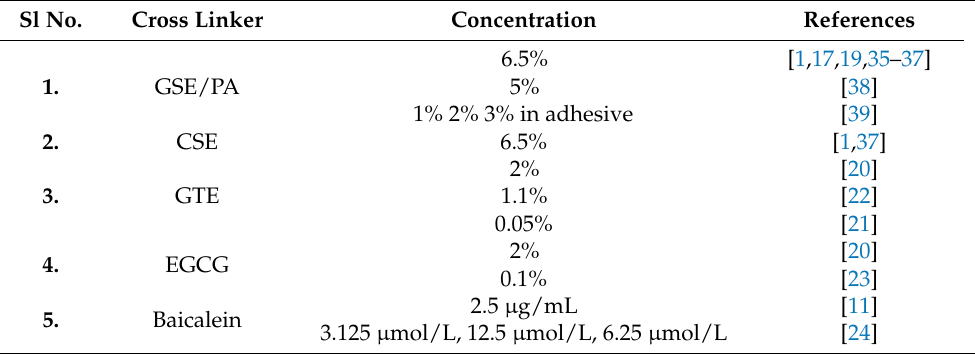
Table 1. The 5 cross linkers and their concentrations assessed in this systematic review. Sl